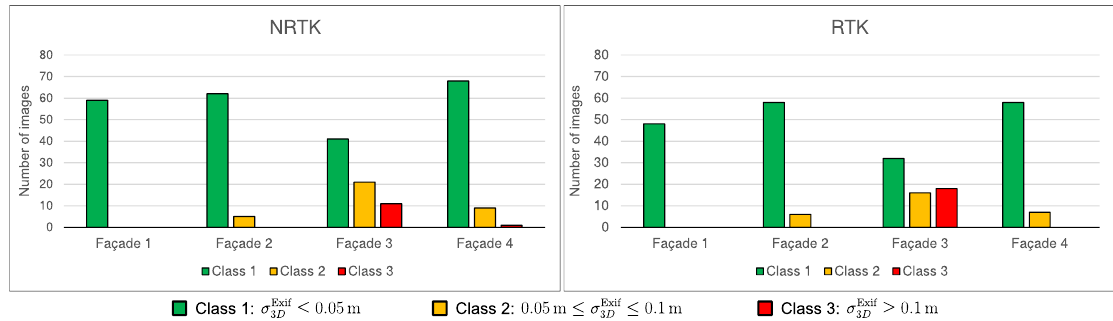
Figure 7. Analysis of input accuracy of camera